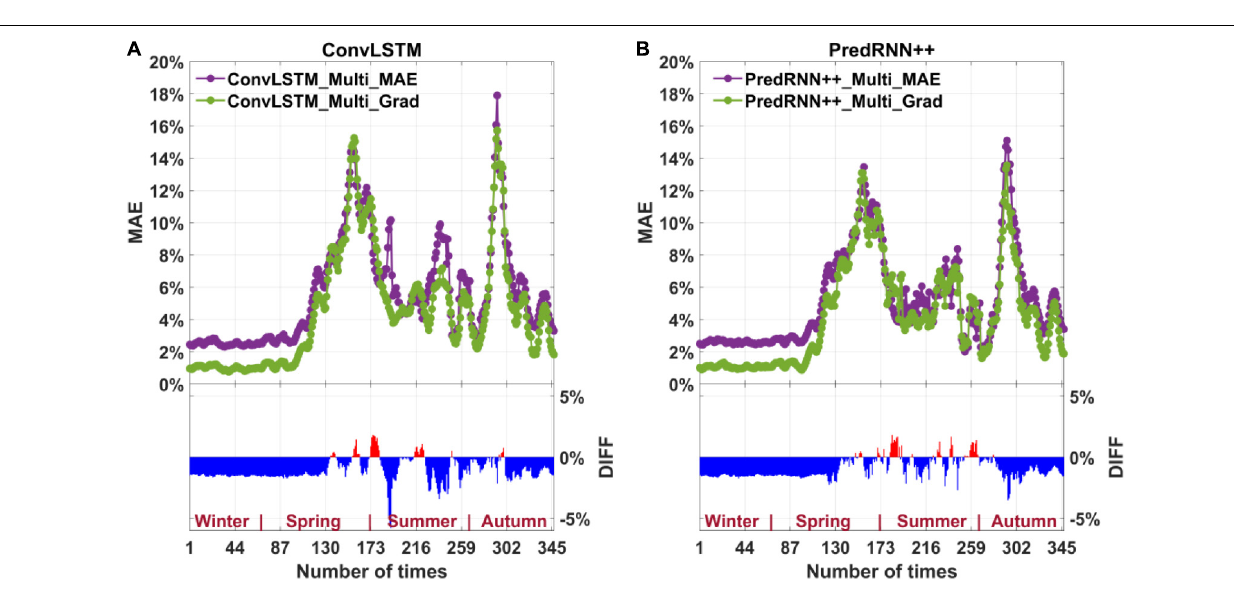
FIGURE 8 | MAE for the multi-factor prediction of ConvLSTM based on MAE-loss and Grad-loss (A) ; MAE for the multi-factor prediction of PredRNN++ based on MAE-loss and Grad-loss (B) . The DIFF in the bar graph is obtained by subtracting the model based on MAE-loss from the model based on